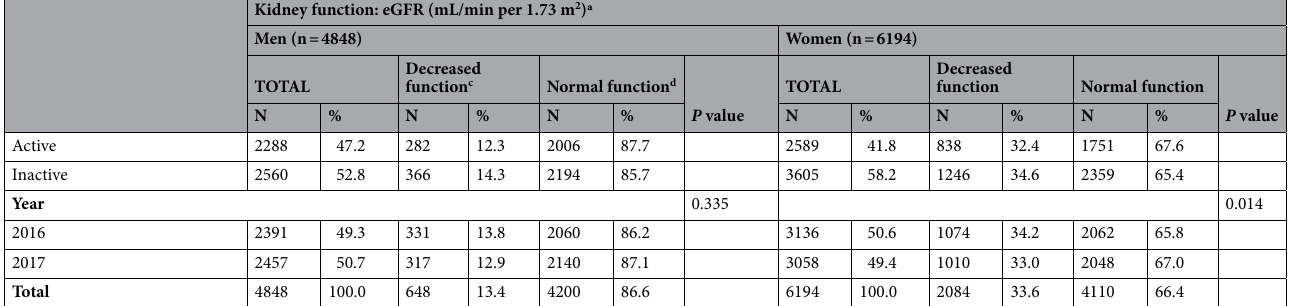
defined by BMI based on the 2018 Clinical Practice Guidelines for Overweight and Obesity in Korea. f Three groups (white, pink, and blue) based on the International Standard Classification of Occupations Codes. Unemployed group includes